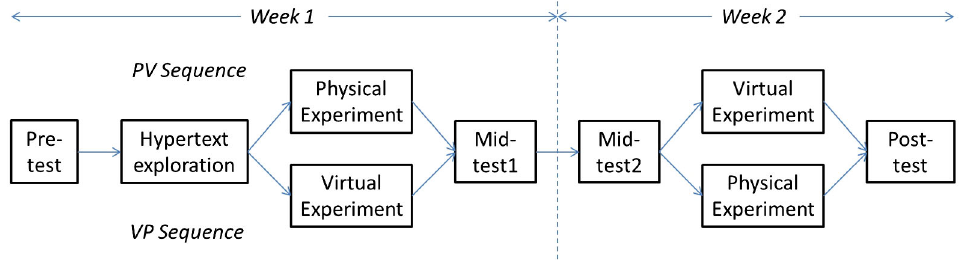
FIG. 4 (color online). The experimental design involved two sequences. In the PV sequence students performed the physical experiment followed by the virtual experiment. In the VP sequence students performed the virtual experiment followed by the physical experiment. All tests were